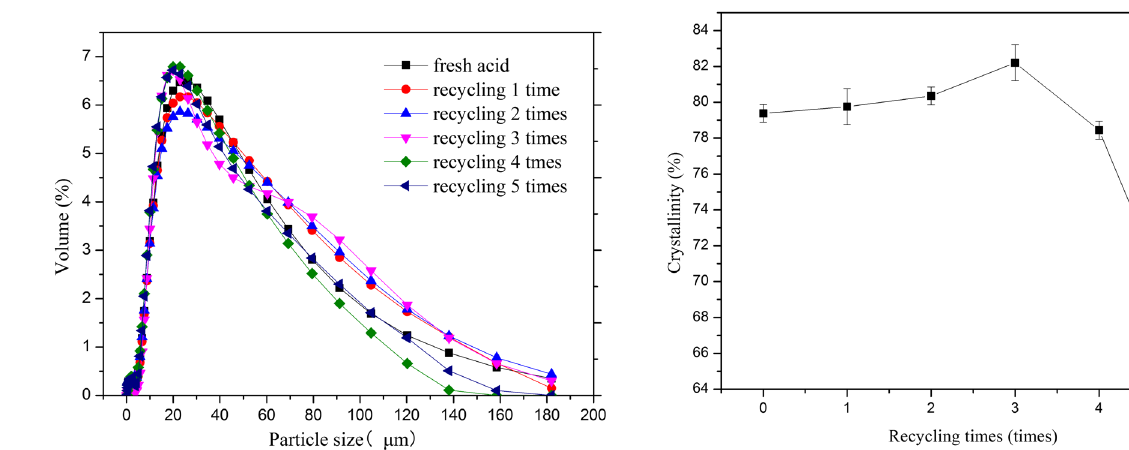
Figure 2: Distribution of cellulose particle size under different waste liquid cycles.